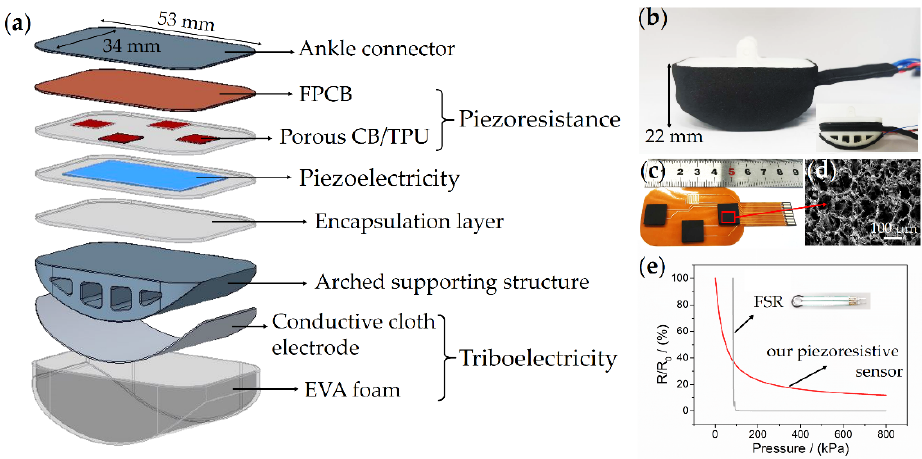
Figure 3. Design and components of the FMSS. ( a ) A cross-section depiction and structural schematic of the FMSS. ( b ) Photographs of the assembled FMSS integrated into the foot structure of the quadruped robot: Pegasus. ( c ) Photographs of the assembled piezoresistive sensor array. ( d ) SEM image showing the sponge-like hierarchical porous piezoresistive elastomer. ( e ) The relative change in resistance (R/R 0 ) of the piezoresistive sensor and the FSR, as a function of pressure (0–800 kPa).